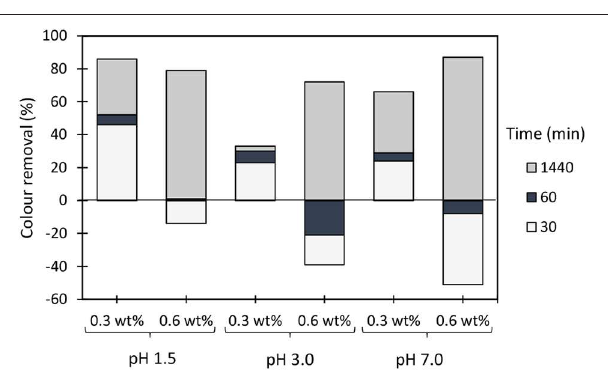
FIGURE 6 | Industrial colored effluent treatment (based on turbidity reduction) when using only bentonite at two different dosages (0.3 and 0.6 wt%) and three different pH levels, 1.5, 3.0, and